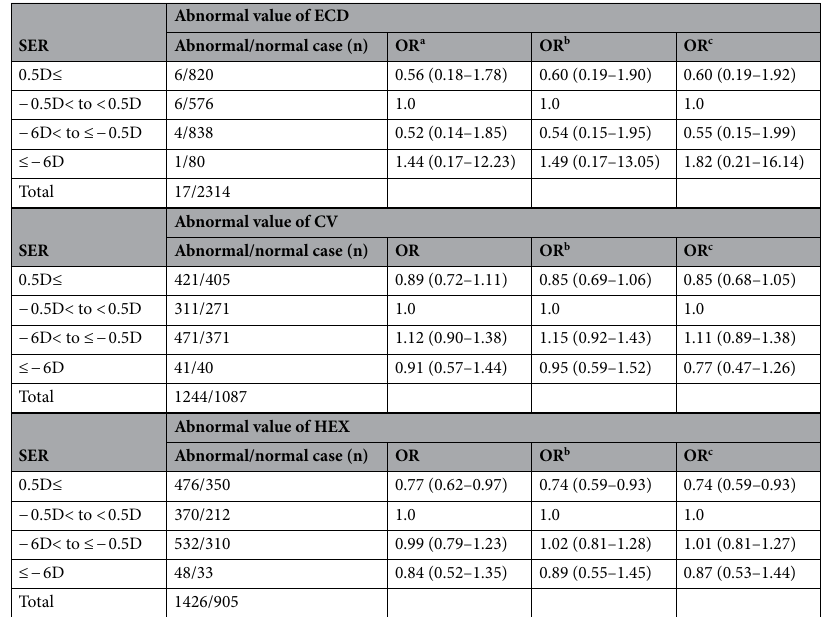
Table 3. Adjusted odds ratio of having the abnormal value of endothelial cell density, coefficient of variation, and hexagonality according to spherical equivalent refraction in male participants. ECD endothelial cell density, CV coefficient of variation, HEX hexagonality, n number, D diopter, OR odds ratio. a Adjusted for age. b Further adjusted for intraocular pressure, keratometric power, height, and antihypertensive drug use. c Further adjusted for a history of contact lenses